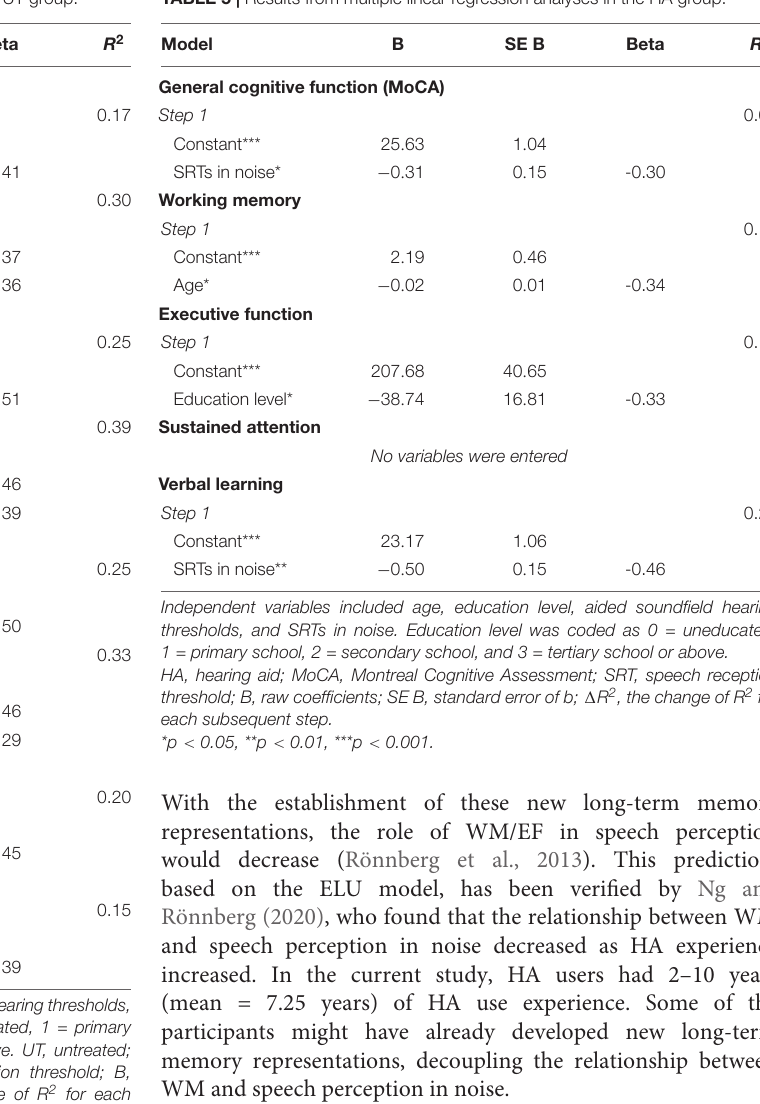
TABLE 4 | Results from multiple linear regression analyses in the UT group. TABLE 5 | Results from multiple linear regression analyses in the HA